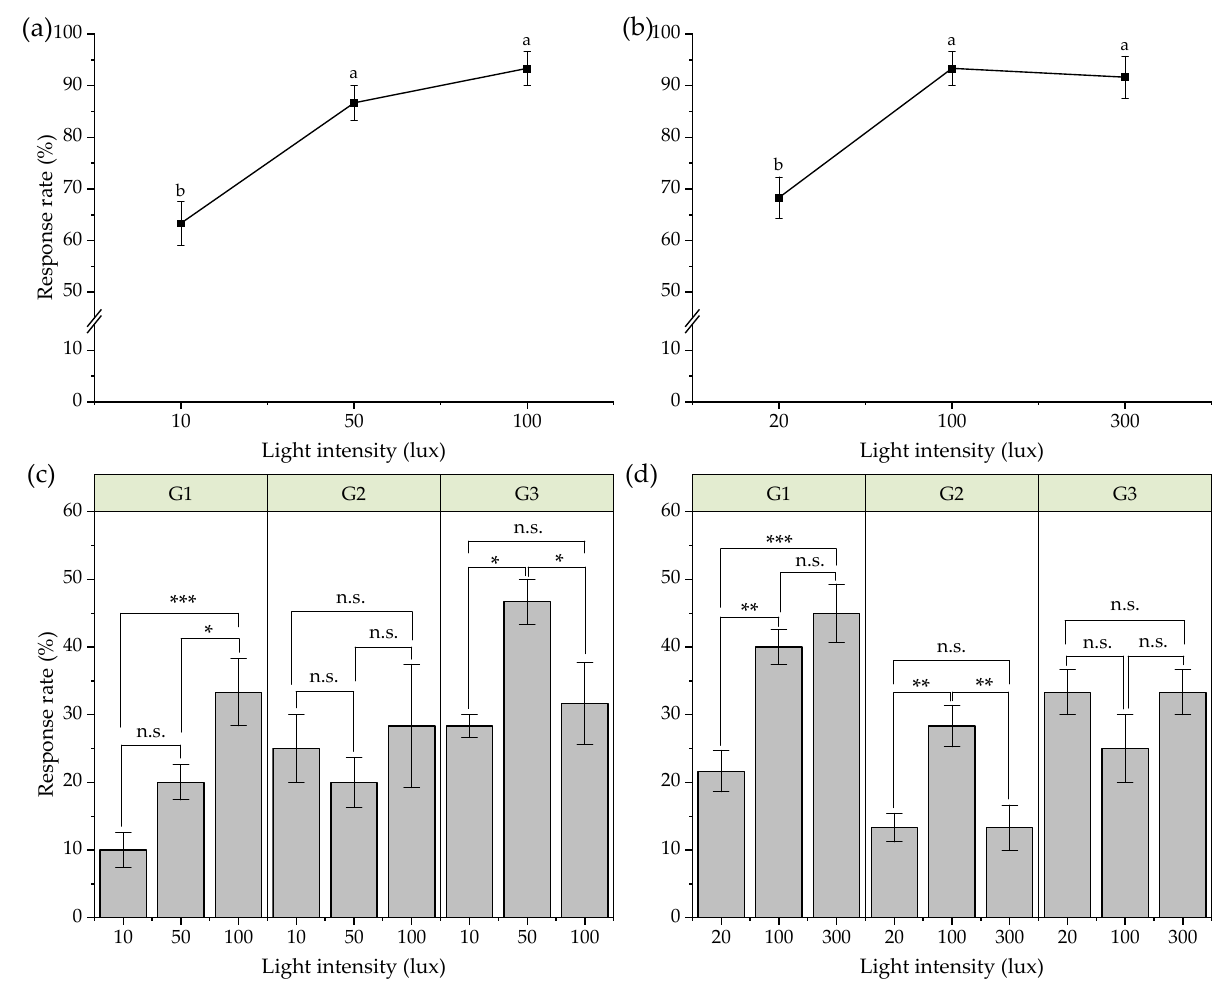
Figure 6. Phototactic behavioral responses of females and males to different light intensities. Photo- tactic rate ( a ) and phototactic reaction intensity ( c ) of females to different light intensities at 365 nm; phototactic rate ( b ) and phototactic reaction intensity ( d ) of males to different light intensities at 420 nm. ( a , b ) Data are means ± SE, different lowercase letters indicate significant differences between light intensity (Tukey’s HSD, p < 0.05); ( c , d ) data are means ± SE, * significant at p < 0.05 level, ** significant at p < 0.01 level, *** significant at p < 0.001 level, n.s. no significant difference, by Tukey’s HSD test.